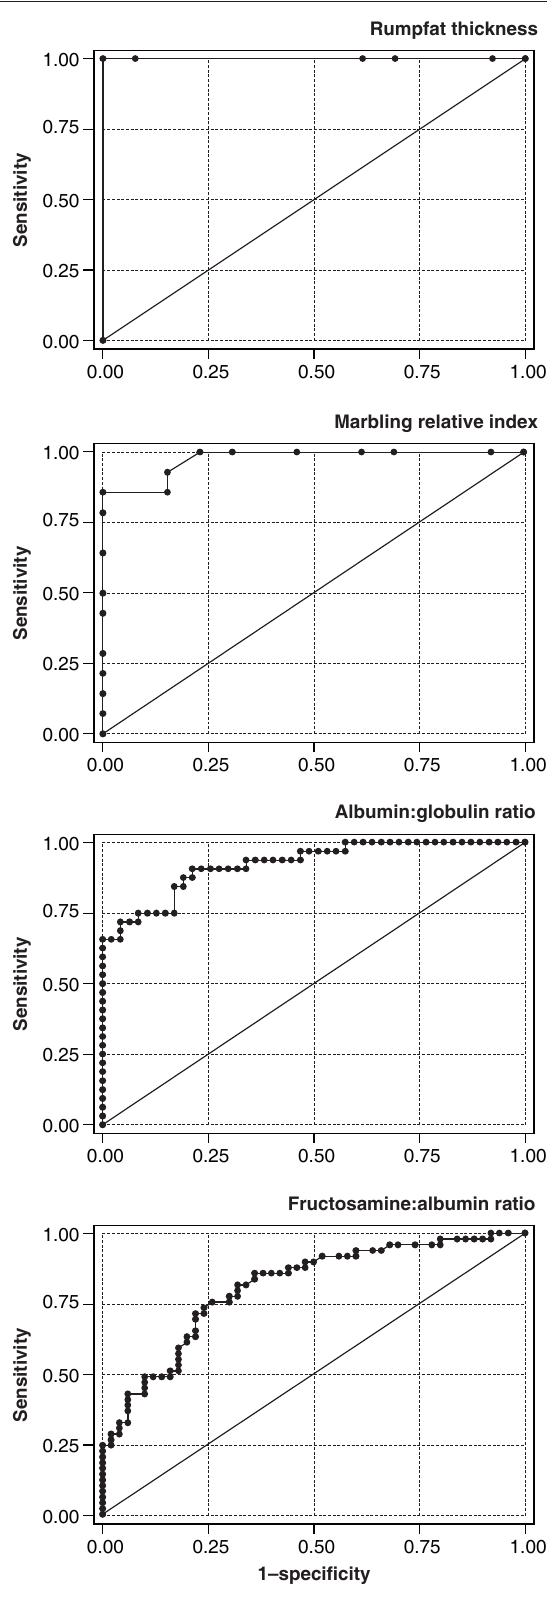
FIG. 1 Receiver operating characteristic (ROC) curves for the discrimination between undernourished (BCS < 1) and adequately nourished (BCS > 2.5) cattle, using various clinical, biochemical and ultrasonographic